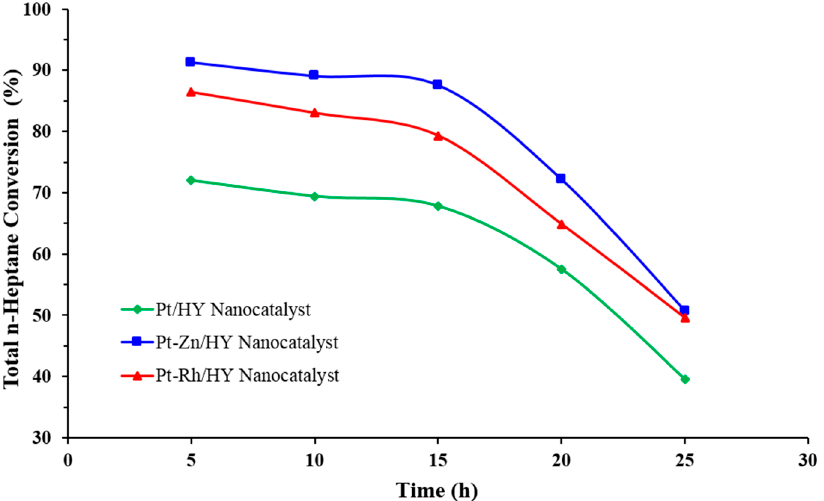
Figure 7. Relationship between the total reaction conversion of n-heptane into products of reformate with the reaction time at a temperature of 500 °C, WHSV = 4, and H 2 /HCs = 4.